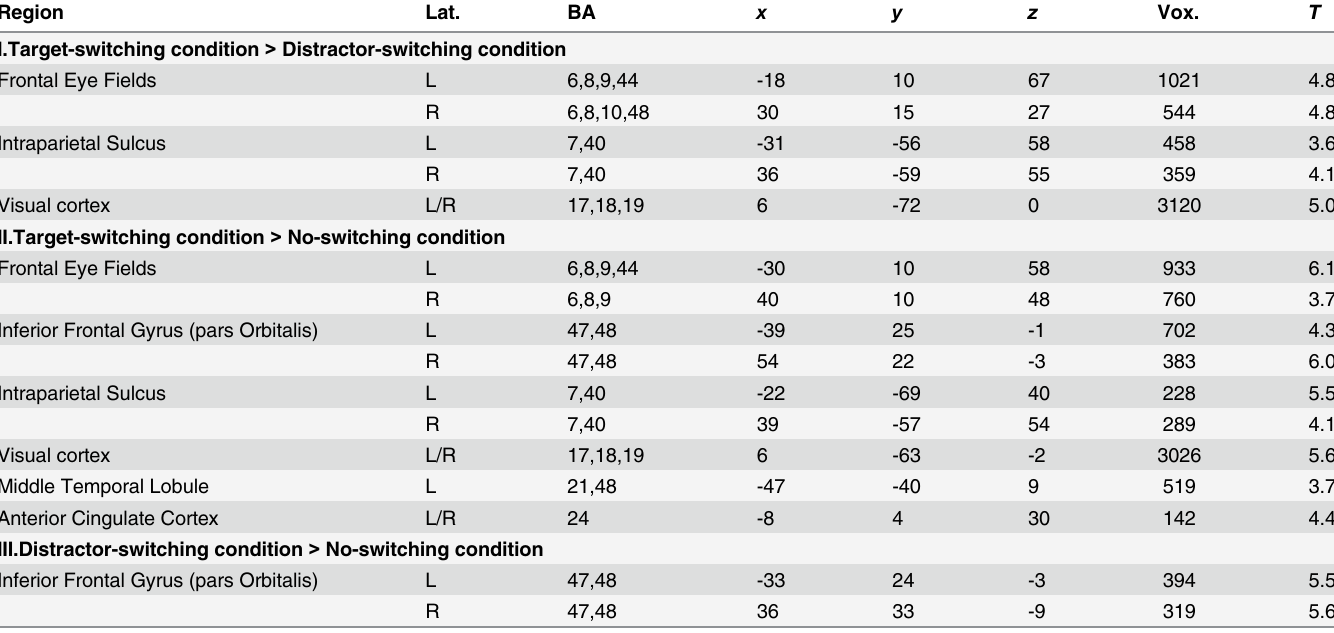
Table 2. Region activation in switch conditions